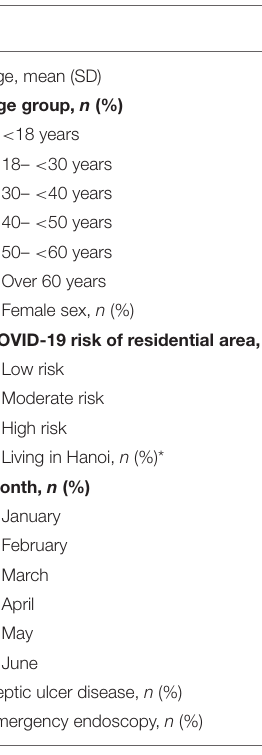
TABLE 1 | Patient characteristics between 2019 and